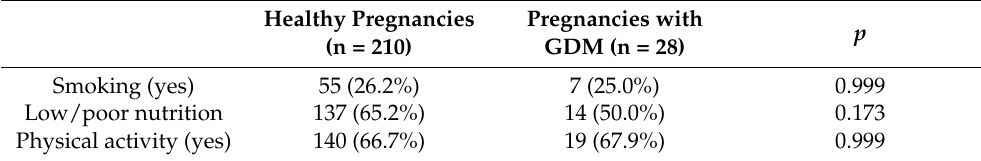
Table 2 . Women’s lifestyle according to health status at the first trimester of gestation .